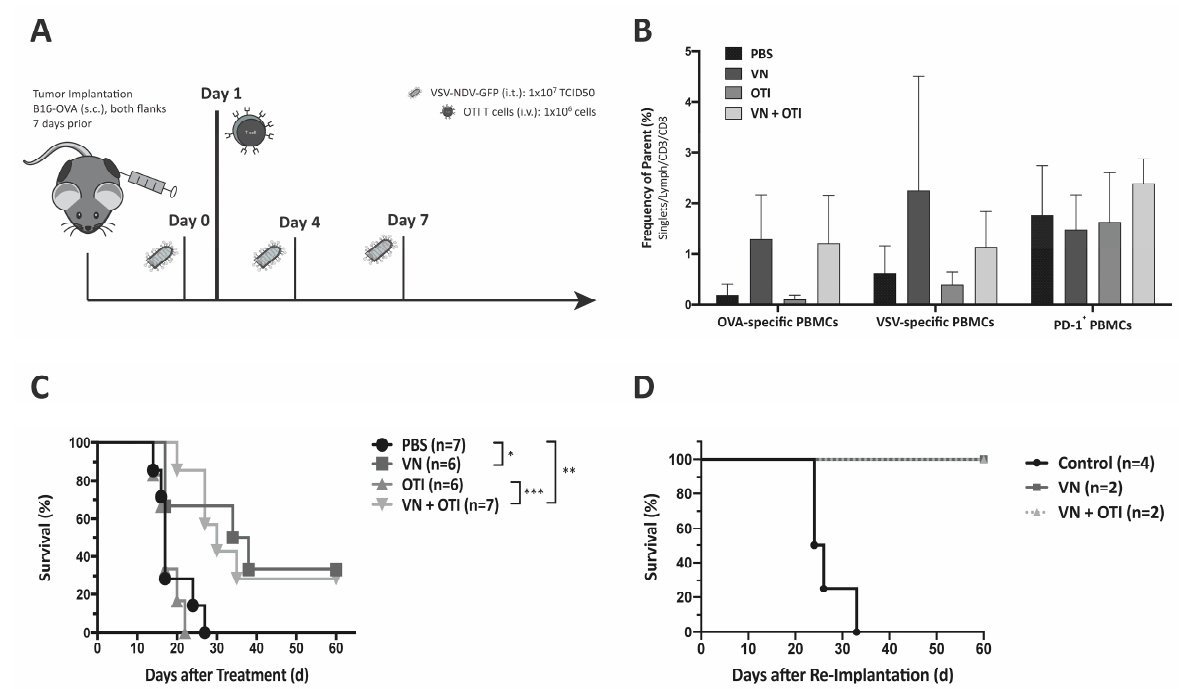
Figure 3. VSV-NDV and combination therapy improve survival in murine melanoma model. ( A ) Experimental set-up of the survival experiment. C57BL6/J mice were implanted with 2.4 × 10 5 (injected tumor) and 1.2 × 10 5 (uninjected tumor) B16-OVA cells subcutaneously on contralateral flanks. One week later, the mice were randomly distributed into treatment groups ( n = 6–7) and injected intratumorally with VSV-NDV (VN) at a dose of 10 7 TCID50 or PBS in an equal volume of 50 μ L on day 0, followed by an intravenous OTI T cell injection (1 × 10 6 ) on day 1 for combination treatment or OTI monotherapy. Intratumoral virus or PBS injections were repeated on day 4 and 7. ( B ) Blood was collected on day 16 after the first treatment to analyze the systemic expansion of OVA- and VSV-specific CD8 + T cells via tetramer staining as well as PD1 expression patterns by flow cytometry. ( C ) Survival of the different treatment groups was monitored and plotted in a Kaplan – Meyer curve. Statistical significance was determined by log-rank test (* p < 0.05, ** p < 0.01, *** p < 0.001). ( D ) Long-term surviving mice treated with VSV-NDV or combination therapy (VN + OTI) (N = 2) were subjected to rechallenge with subcutaneous implantation of 1.2 × 10 5 B16-OVA cells in a 100 μ l volume. Previously untreated age- and sex-matched C57BL6/J mice were similarly implanted with B16-OVA cells as a control. Survival was monitored and plotted in a Kaplan – Meier curve.